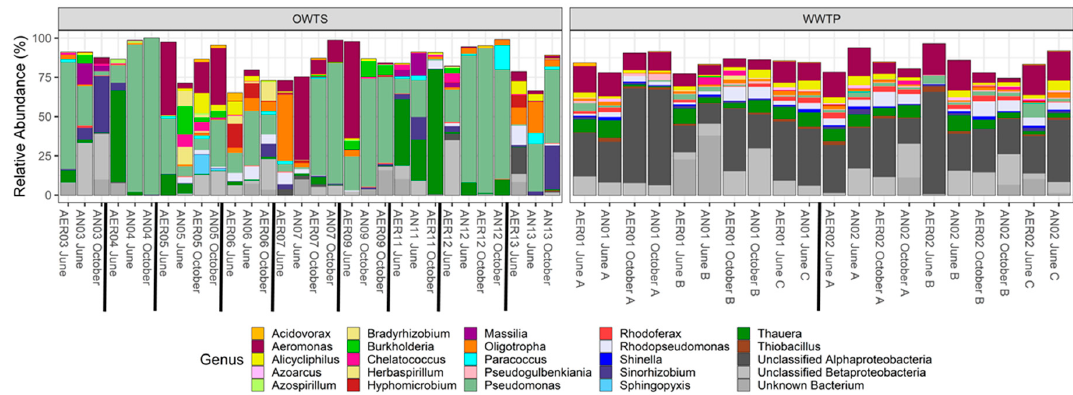
Figure 4. Relative abundance of the 50 most abundant nosZ taxa in a biological nitrogen removal (BNR) wastewater treatment plant (WTP) and in advanced N-removal onsite wastewater treatment systems (OWTS). Labels indicate component (AER = oxic; AN = anoxic), system number, month sampled, and replicate letter (A, B, C; WTP only). WTP = systems 01 and 02; OWTS = systems 03 to 13.